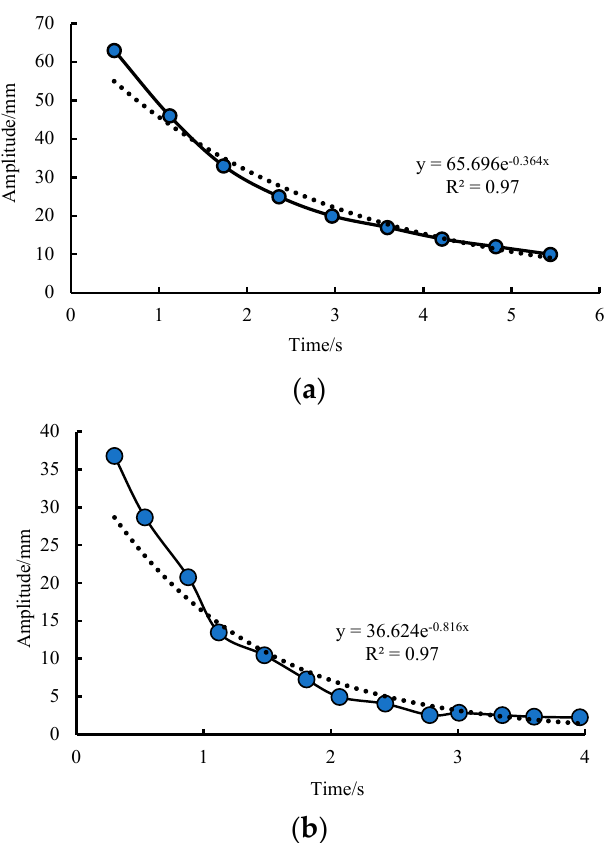
Figure 10. Fitting diagram of the attenuation function of each peak amplitude of the rape plant. ( a ) Lateral branch. ( b ) Main branch. Taking the side branch as the node, the free attenuation vibrations of the marked points 20 cm, 30 cm, and 40 cm away from the node were recorded, and the attenuation coefficient of each point was measured. The attenuation coefficient of each point is shown in Figure 11.